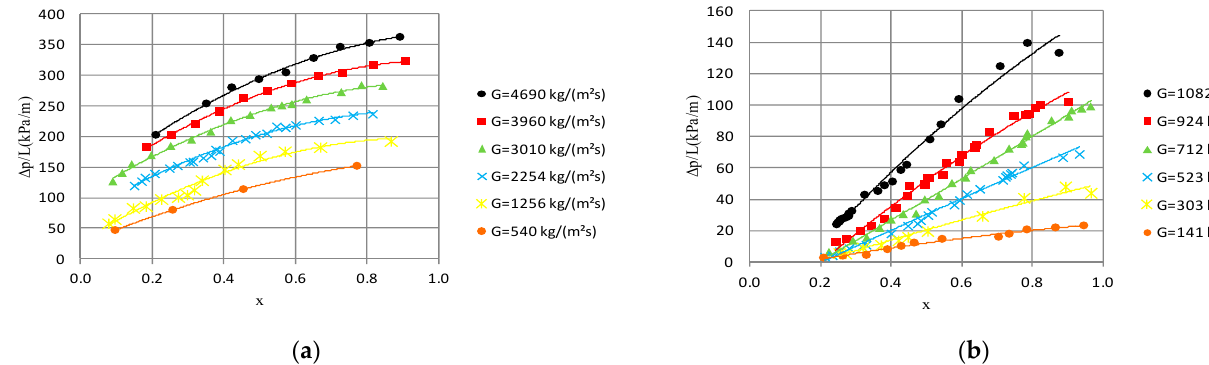
Figure 7. Dependence of heat transfer coefficient on internal diameter of minichannel α = f(d i ) for G ≈ 519 kg/m 2 s, inlet T s = 39 °C.